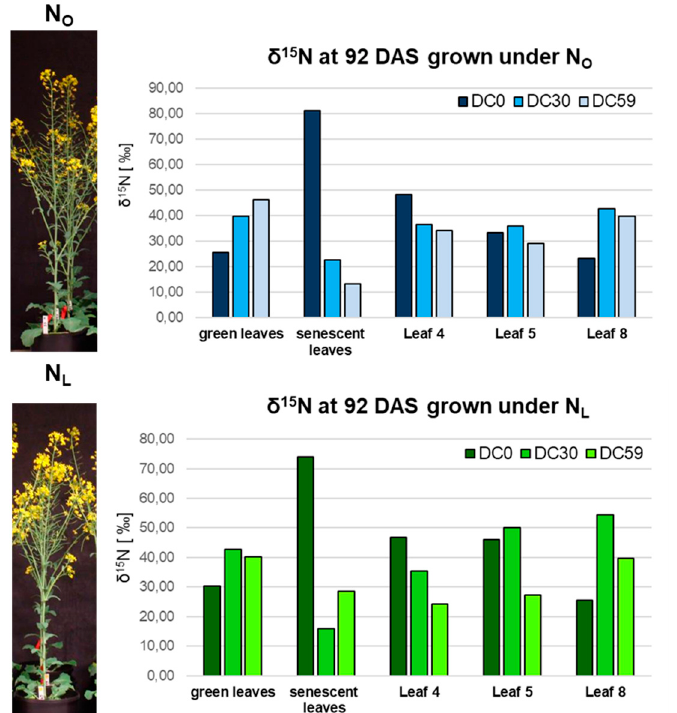
Figure 4. Nitrogen recovery and the distribution of the labeled N to different organs. δ 15 N signatures at 92 DAS (days after sowing) in pooled green and senescent leaves as well as in leaves No. 4, No. 5 and No. 8 of plants grown under N L (lower chart) and under N O (upper chart) conditions are presented (DC0: fertilization at 0 DAS, “old N”, DC30: fertilization at 72 DAS, DC59: fertilization at 80 DAS, “new N”). The stable isotope ratio 15 N/ 14 N was related to the isotopic signature of N 2 in the air and is reported here as “delta” δ values in ‰. Exactly the same plant material was used for the microarray analyses of Safavi-Rizi et al., [19] and physiological analyses in Franzaring et al. [20,21].